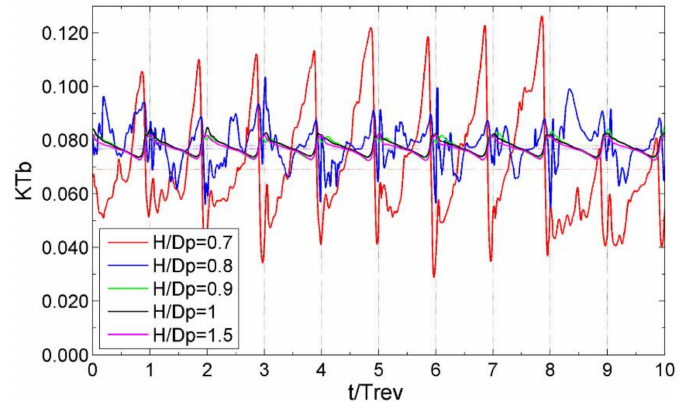
Figure 29. Computed time histories of single blade thrust, KTb, for different magnitudes of submergence, H/Dp, at J =